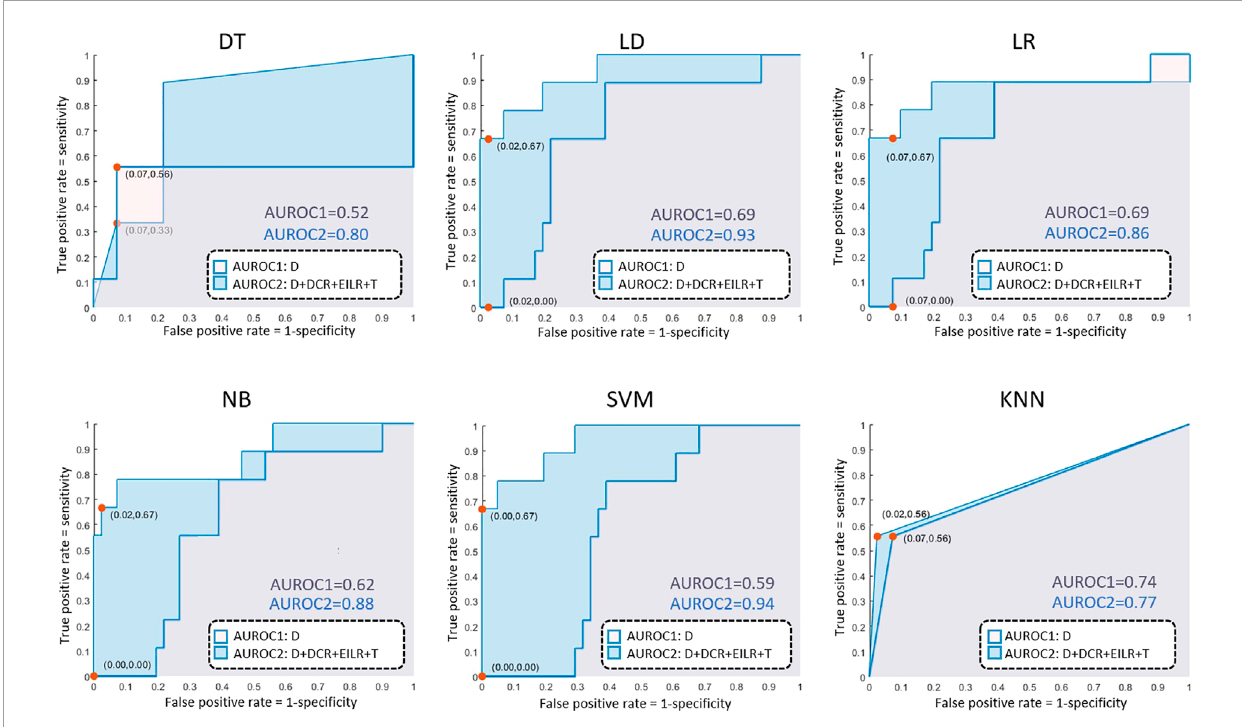
FIGURE 4 AUROC results for the decision tree (DT), linear discriminant (LD), logistic regression (LR), naive bayes (NB), support vector machine (SVM), k-nearest neighbours (KNN) classifiers.